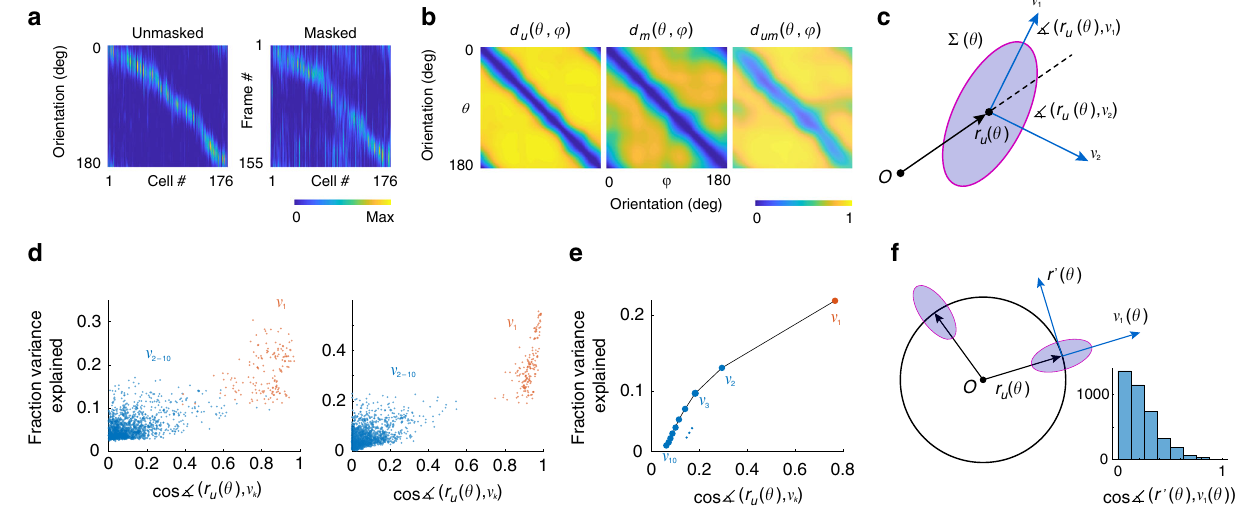
Fig. 3 Characterization of population responses. a Responses of a population of neurons in the unmasked and masked conditions. Cells were ordered according to their preferred orientation, thus resulting in a diagonal structure. The rows for these matrices represent the population responses in the unmasked and masked conditions, r u θ ð Þ and r m θ ð Þ . These curves describe a close curve as θ describes one cycle. b . The intrinsic geometry of the curves is captured by the cosine distances between the representation of two orientations in the unmasked condition, d u θ ; φ ð Þ (left panel), and masked condition, d θ ; φ ð Þ (middle panel). The relative positions of the curves with respect to each other is measured by the cosine distance between r m denoted by d um θ ; φ ð Þ (right panel). c . Simpli fi ed schematic showing the mean response to an orientation r u θ ð Þ along with its covariance matrix and the